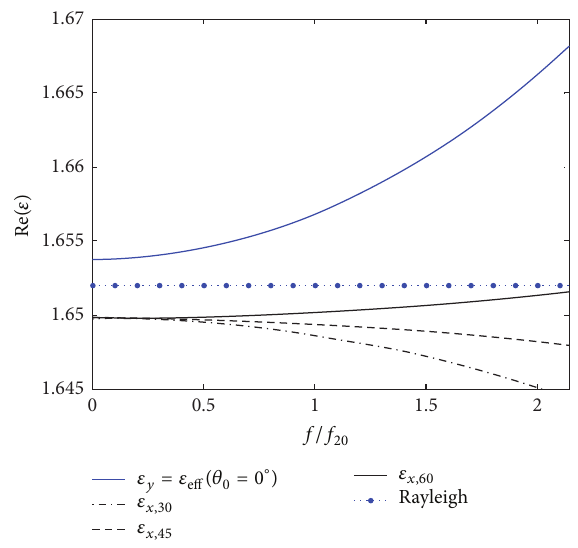
Figure 10: Retrieved 𝜀 𝑥 of the A-model for various incidence angles (𝜃 = 0) . The subscript numerals denote the when 𝜀 𝑦 is fixed as 𝜀 0 eff incidence angles.